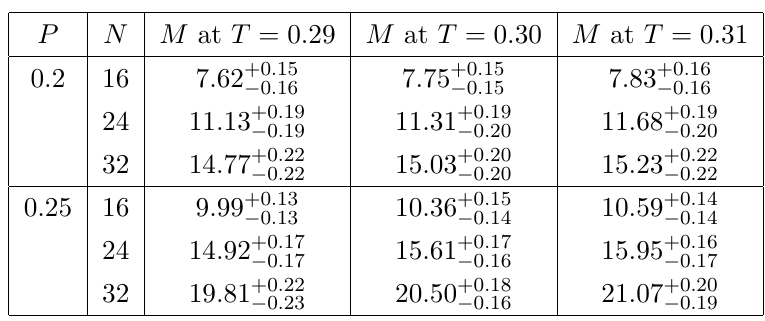
Table 2. P vs M at three different temperatures for n t = 24 . The central value of M is the median of the posterior predictive distribution. The lower and upper bound are the 16 % and 84 % quantiles, respectively.